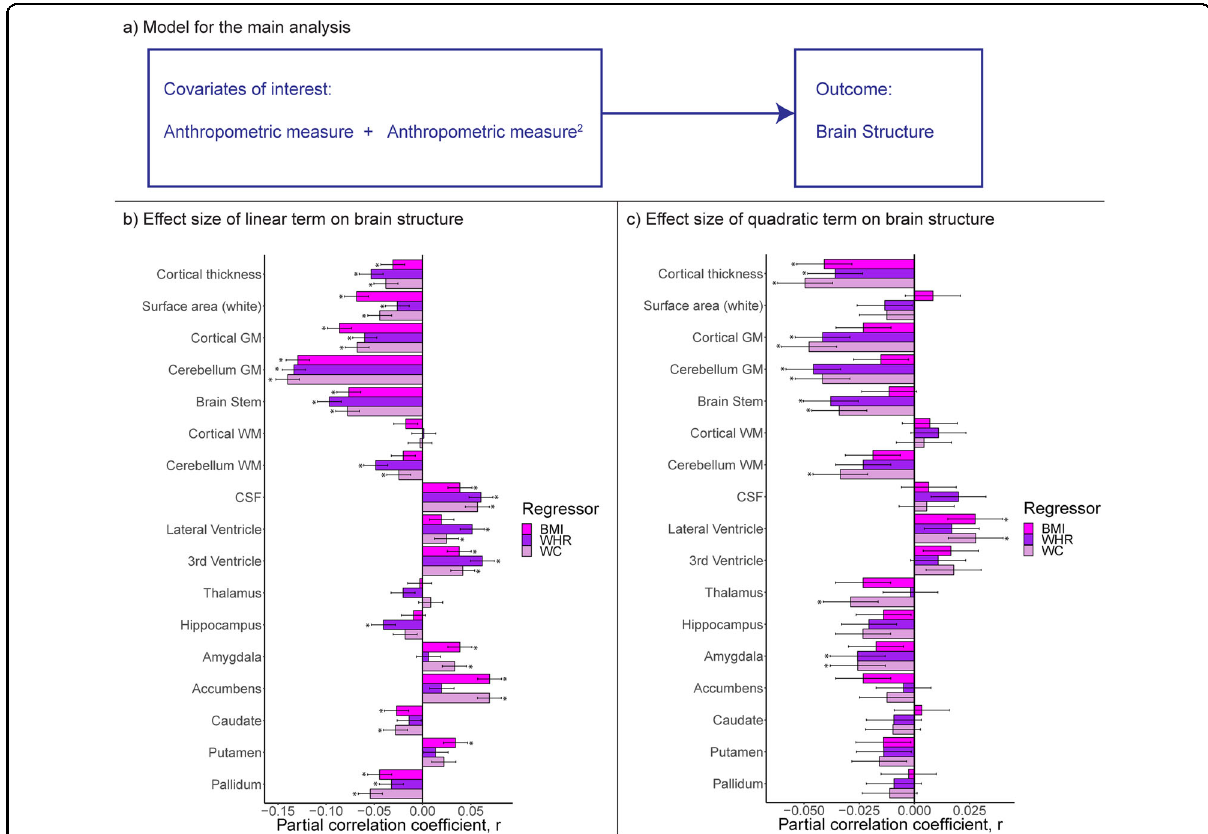
Fig. 2 Body – brain association patterns for anthropometric measures ( n = 24,728). Results from model 2c ( a ) that investigates body – brain connections through the inclusion of linear ( b ) and quadratic ( c ) terms of anthropometric measures. The regression model was adjusted for age, age 2 , sex, age-by-sex, age 2 -by-sex, intracranial volume (except cortical thickness), lifestyle/metabolic factors, Euler number, and site. Signi fi cant associations indicated by asterisk. Dependent variables CSF, lateral/3rd ventricle were log-transformed. BMI body mass index, GM gray matter, WC waist circumference, WHR waist-to-hip ratio, WM white